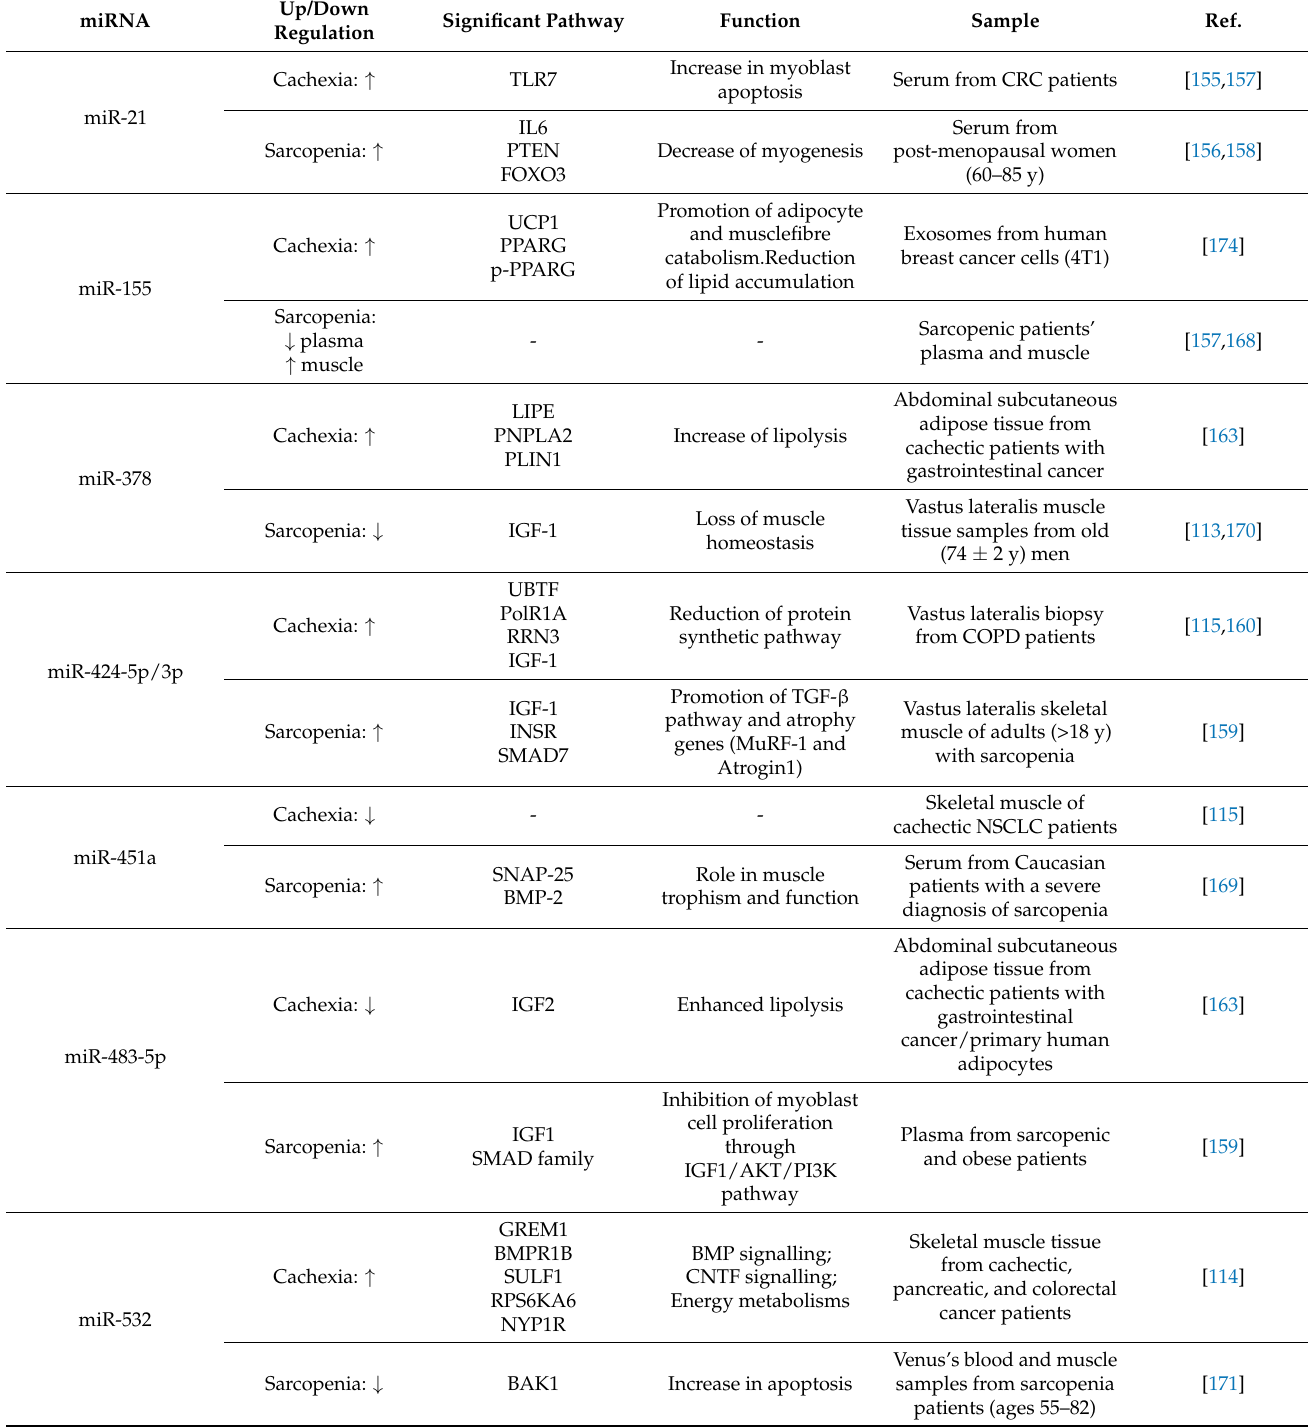
Table 3. Cachexia/Sarcopenia—shared human